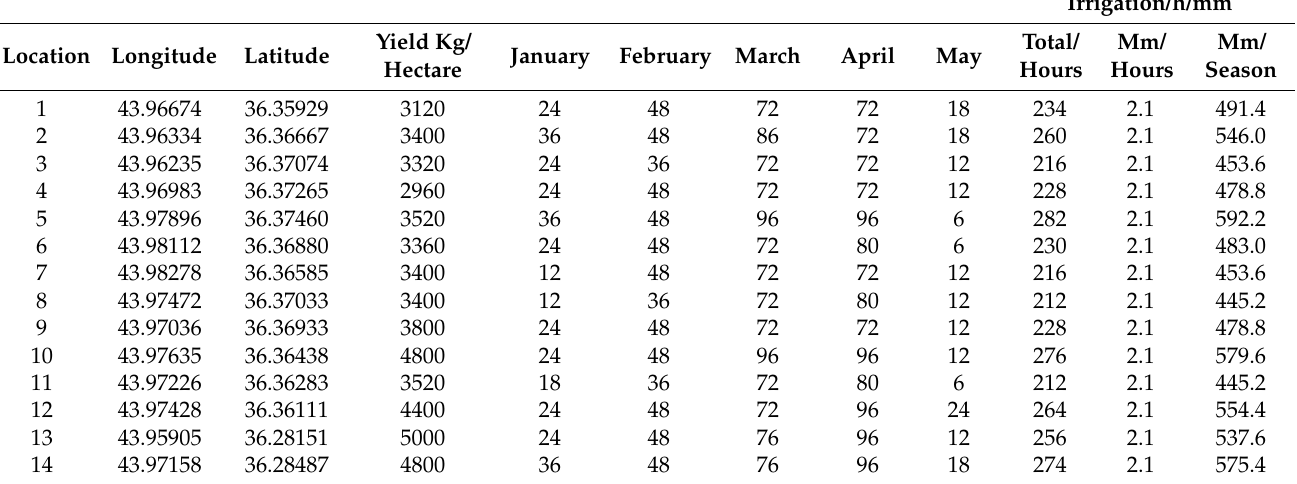
Table 3. The fourteen fields were monitored during five months of irrigation, with irrigation hours used for each center pivot by